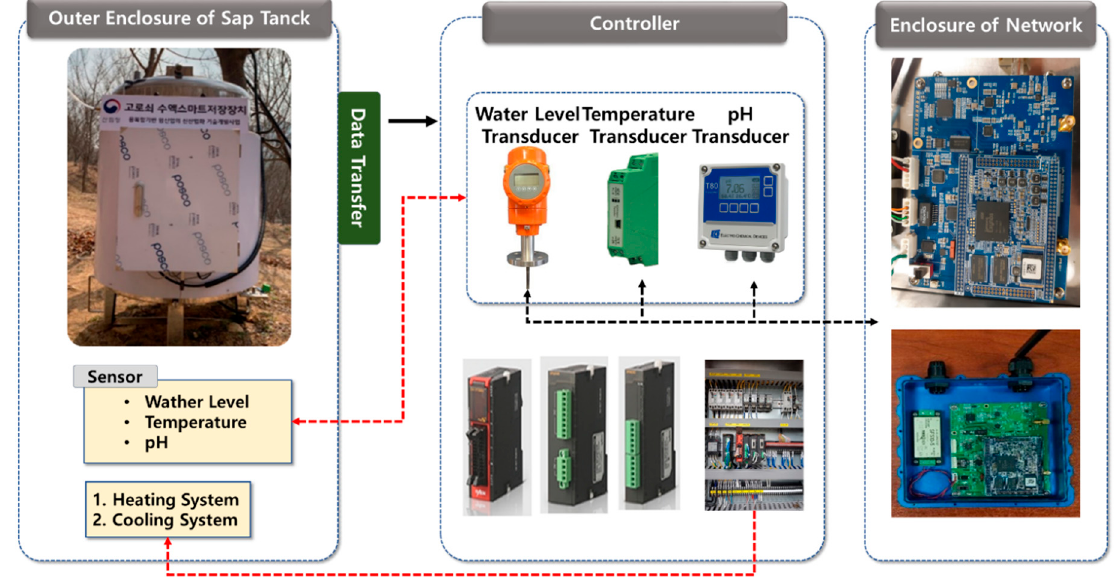
Figure 4. Control board of smart collection tank.